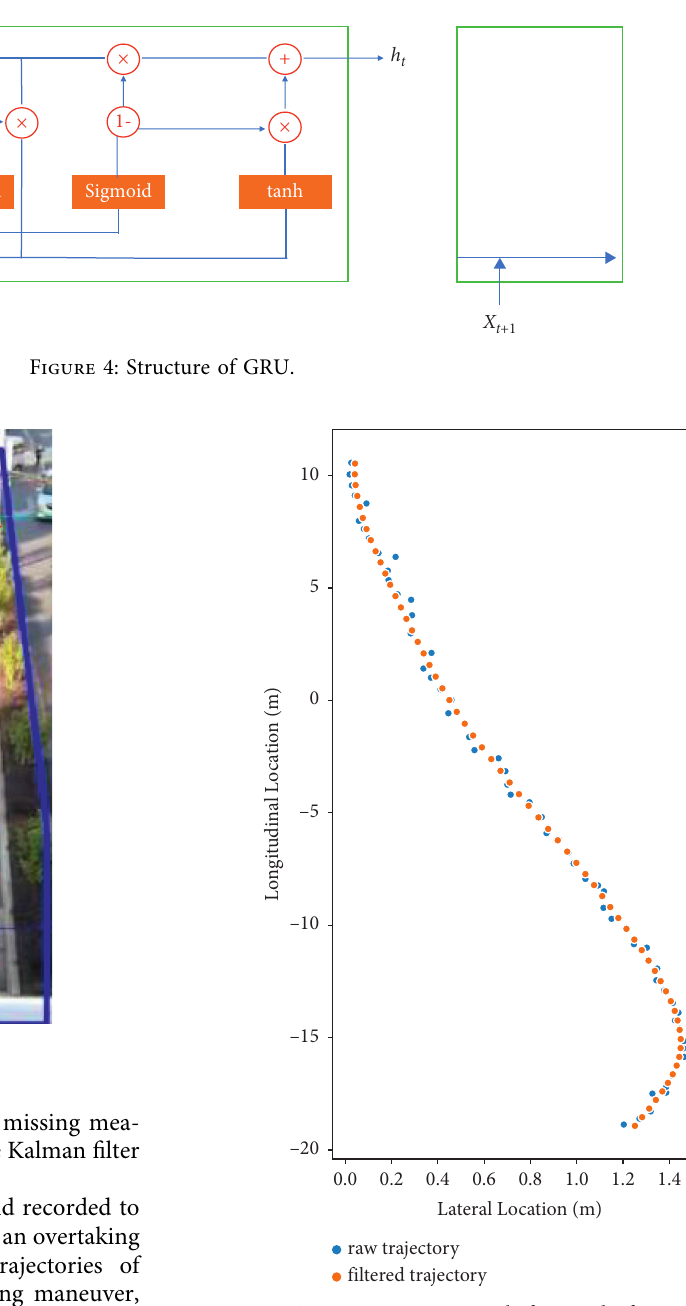
Figure 6: Trajectory comparison before and after applying the Kalman